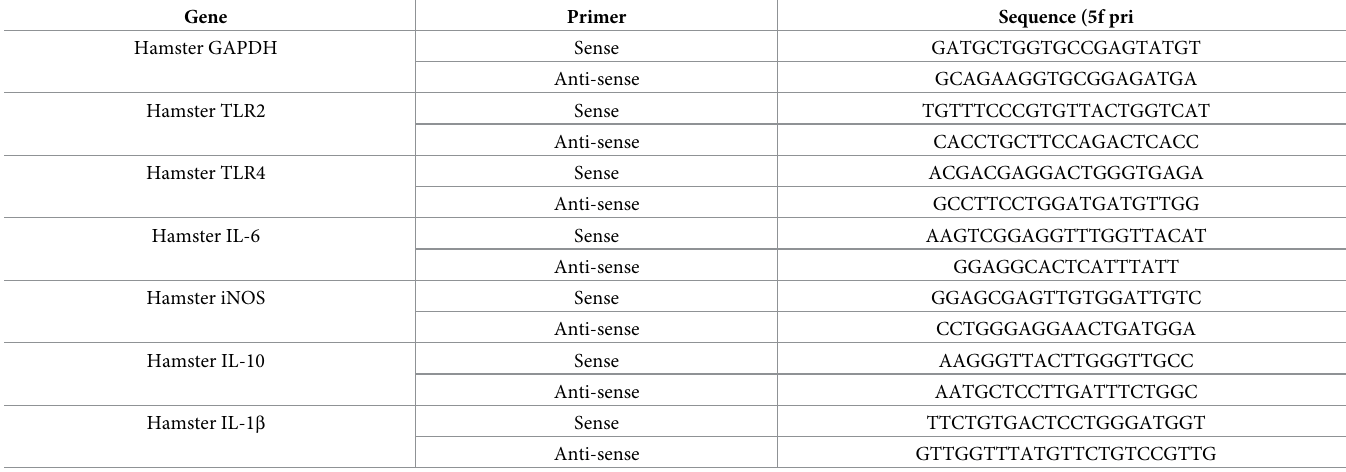
Table 1. Sequence of primers used for qPCR